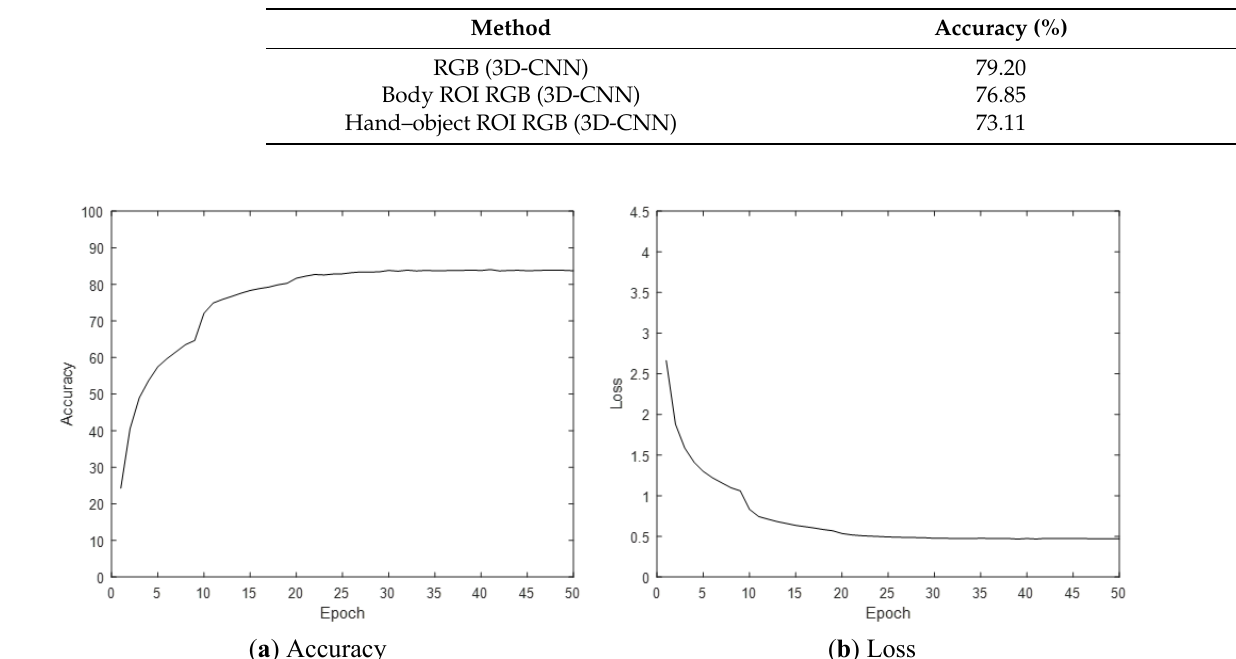
Figure 21. Graph of body ROI-based 3D-CNN learning process.